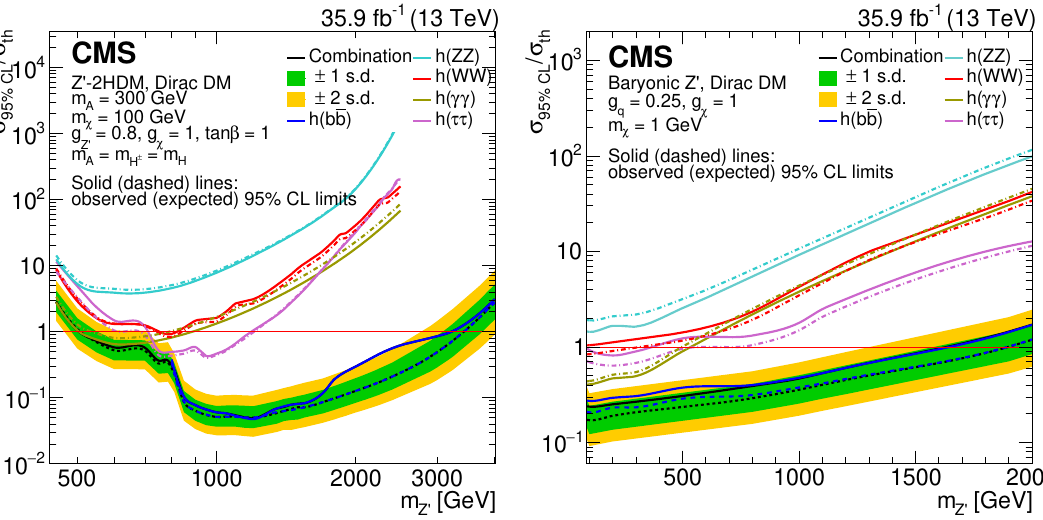
Figure 8 . The upper limits at 95% CL on the observed and expected (cid:27)=(cid:27) and baryonic Z 0 (right) model for the (cid:12)ve individual decay modes of the Higgs boson, and for their combination. The distributions are shown as a function of m m = 1 GeV (baryonic Z 0 model). The inner and outer shaded bands show the 68 and 95% CL (cid:31) uncertainties in the expected limit, respectively.